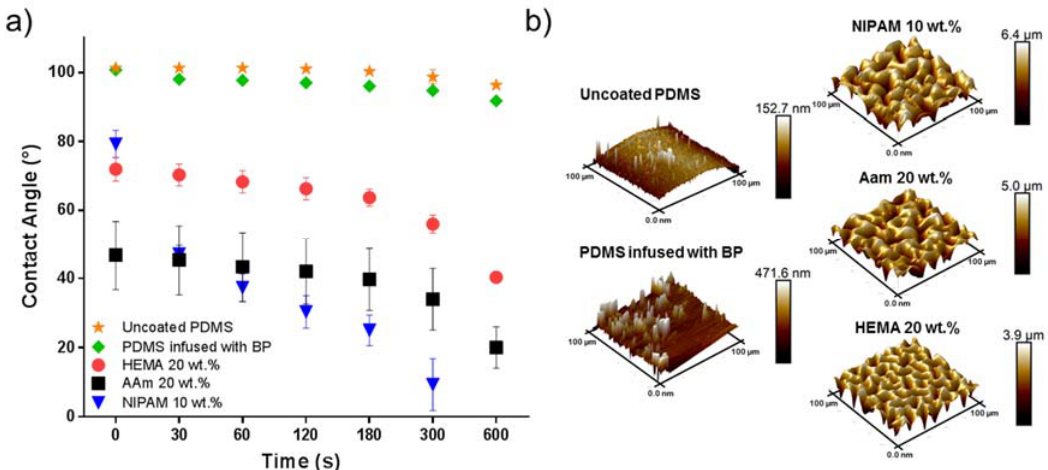
Figure 2. ( a ) Contact angle measurements as a function of time and ( b ) surface morphology images captured by AFM of an uncoated PDMS surface; PDMS infused with benzophenone (BP); and PDMS surface coated with N -Isopropylacrylamide (NIPAM) 10 wt %, 2-Hydroxyethyl methacrylate (HEMA) 20 wt %, and acrylamide (AAm) 20 wt % (UV irradiation time is 10 min).